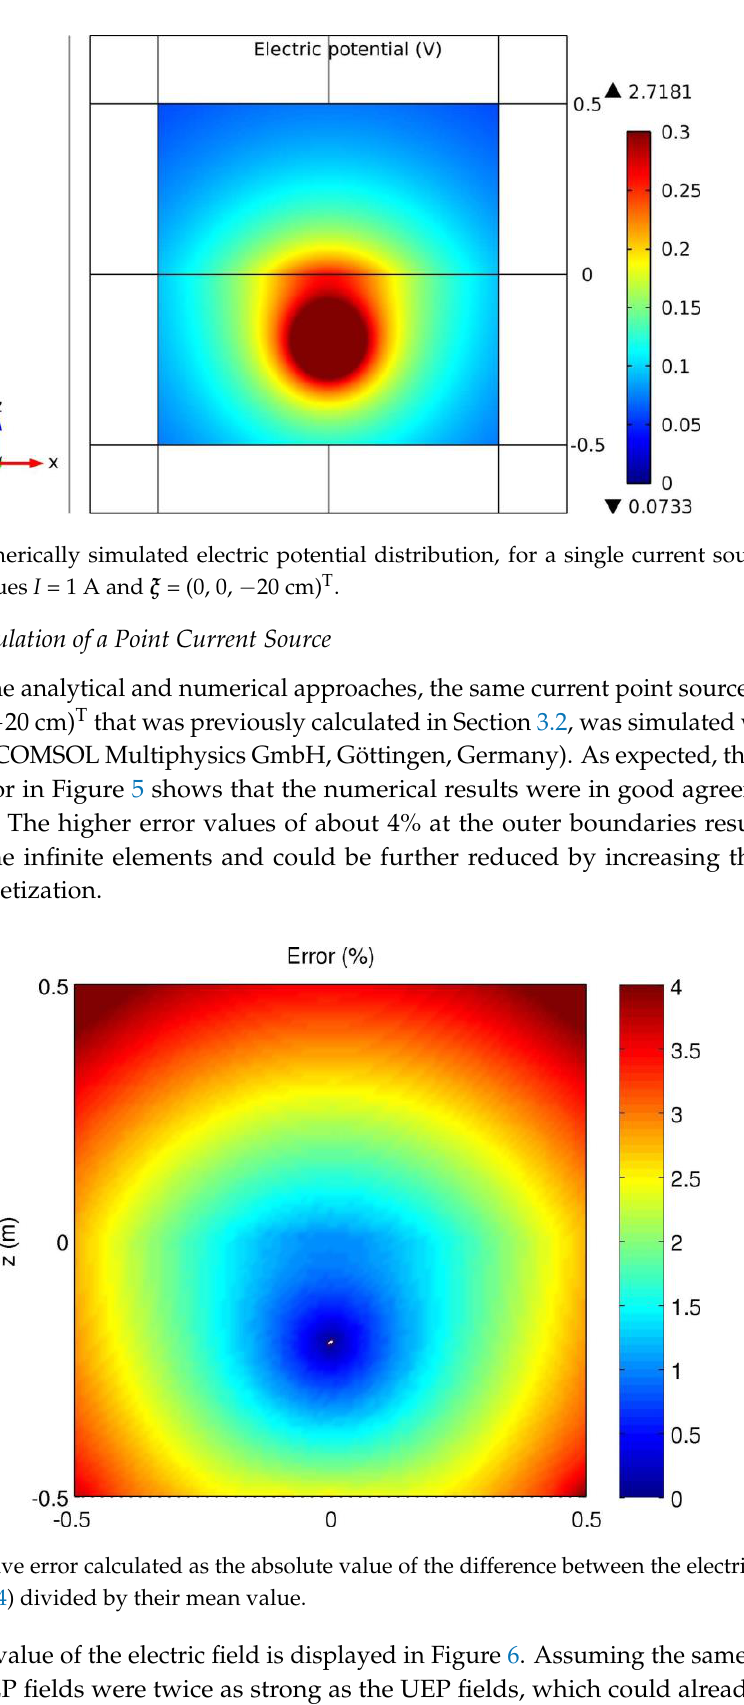
Figure 5. Relative error calculated as the absolute value of the difference between the electric potential (Figures 3 and 4) divided by their mean value.